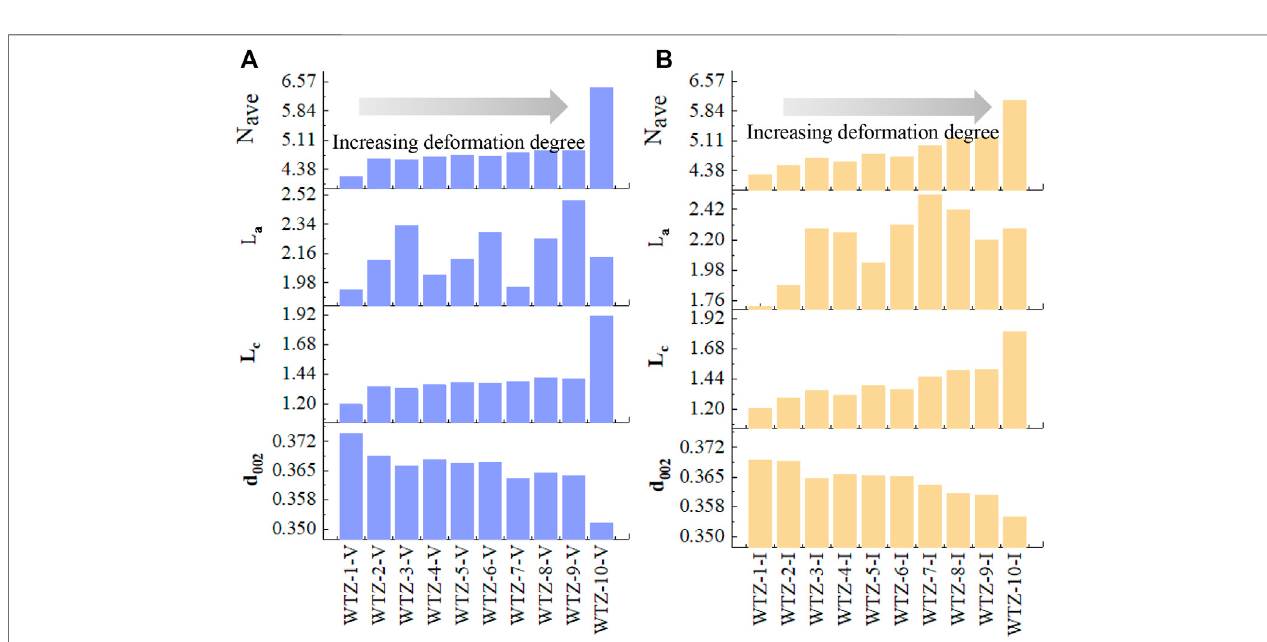
FIGURE 6 | XRD parameters of vitrinite (A) and inertinite (B) .